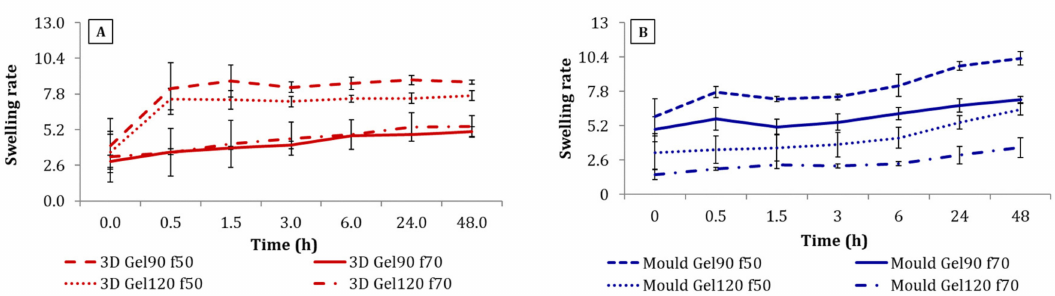
Figure 5. Swelling ratios for 3D-printed ( A ) and mould-casted ( B ) scaffolds represented as mean with st.dev. bars.